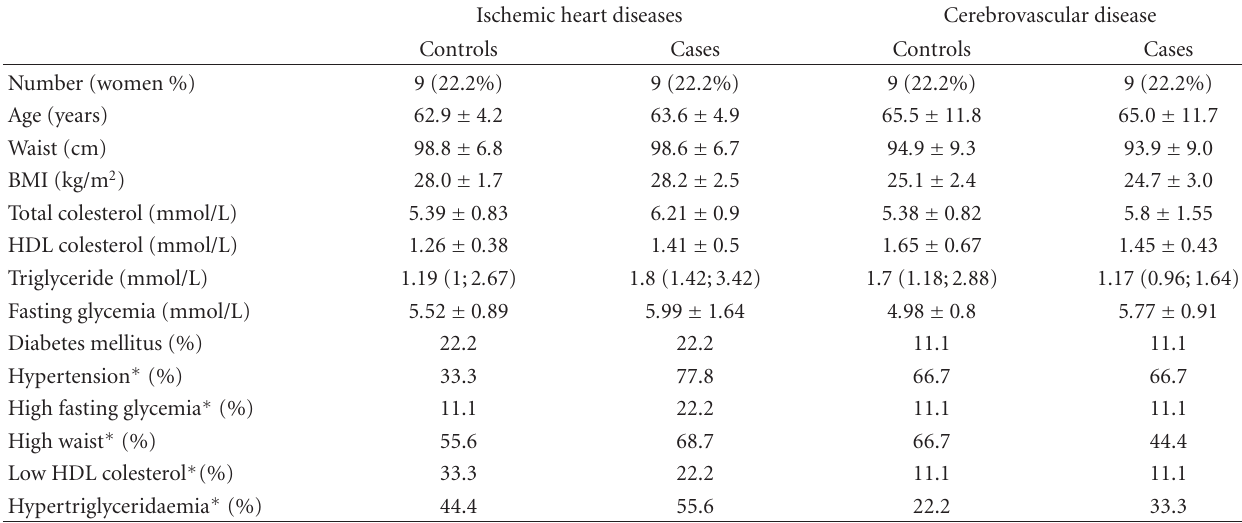
Table 1: Principal characteristics of the sample enrolled are described in the table. Ischemic heart diseases Cerebrovascular